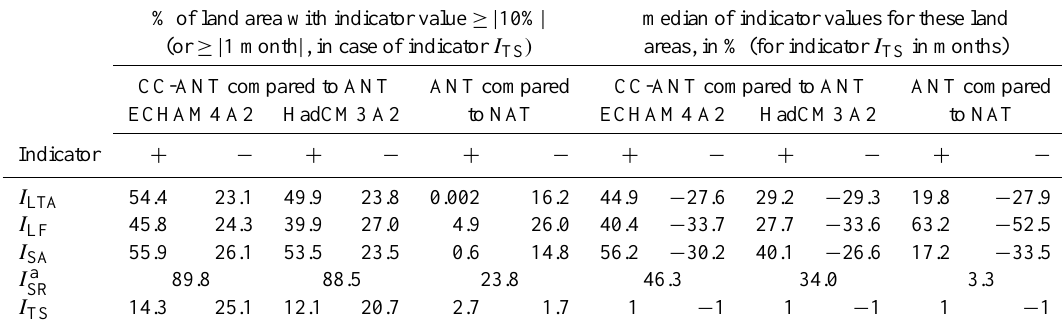
Table 2. Global characterization of river flow regime alteration due to climate change until the 2050s, as compared to historic climate 1961–1990, and due to water withdrawals and reservoirs around the year 2000, as compared to naturalized conditions. In the “CC-ANT compared to ANT” columns, the change in river flow regimes between 1961–1990 and 2041–2070 is shown, assuming water withdrawals and reservoirs representative for the year 2000. As climate scenarios, the A2 emissions scenario as interpreted by the global climate models ECHAM4 and HadCM3 were used. In the “ANT compared to NAT” columns, the impact of water withdrawals and dams for the climate 1961–1990 is shown. Greenland and Antarctica are not taken into account. In columns with “ + ” header, the percent of land area in which the indicator is at least 10% (or one month) is shown, in columns with “ − ” header, the percent of land area in which indicator is minus 10% or smaller (or minus one month). % of land area with indicator value ≥| 10% | median of indicator values for these land (or ≥| 1 month | , in case of indicator I TS ) areas, in % (for indicator I TS in months) CC-ANT compared to ANT ANT compared CC-ANT compared to ANT ANT